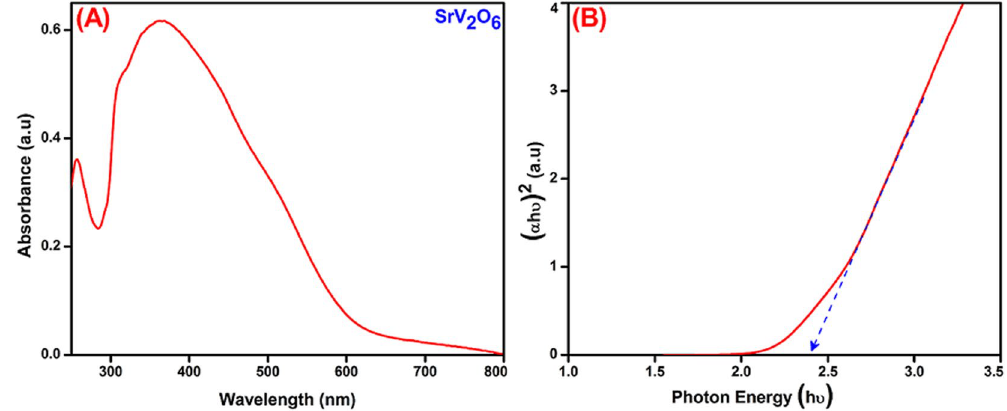
Figure 5. UV-Vis diffuse reflectance spectra (DRS) ( A ) and Energy gap spectra of rod-like SrV 2 O 6 ( B ).